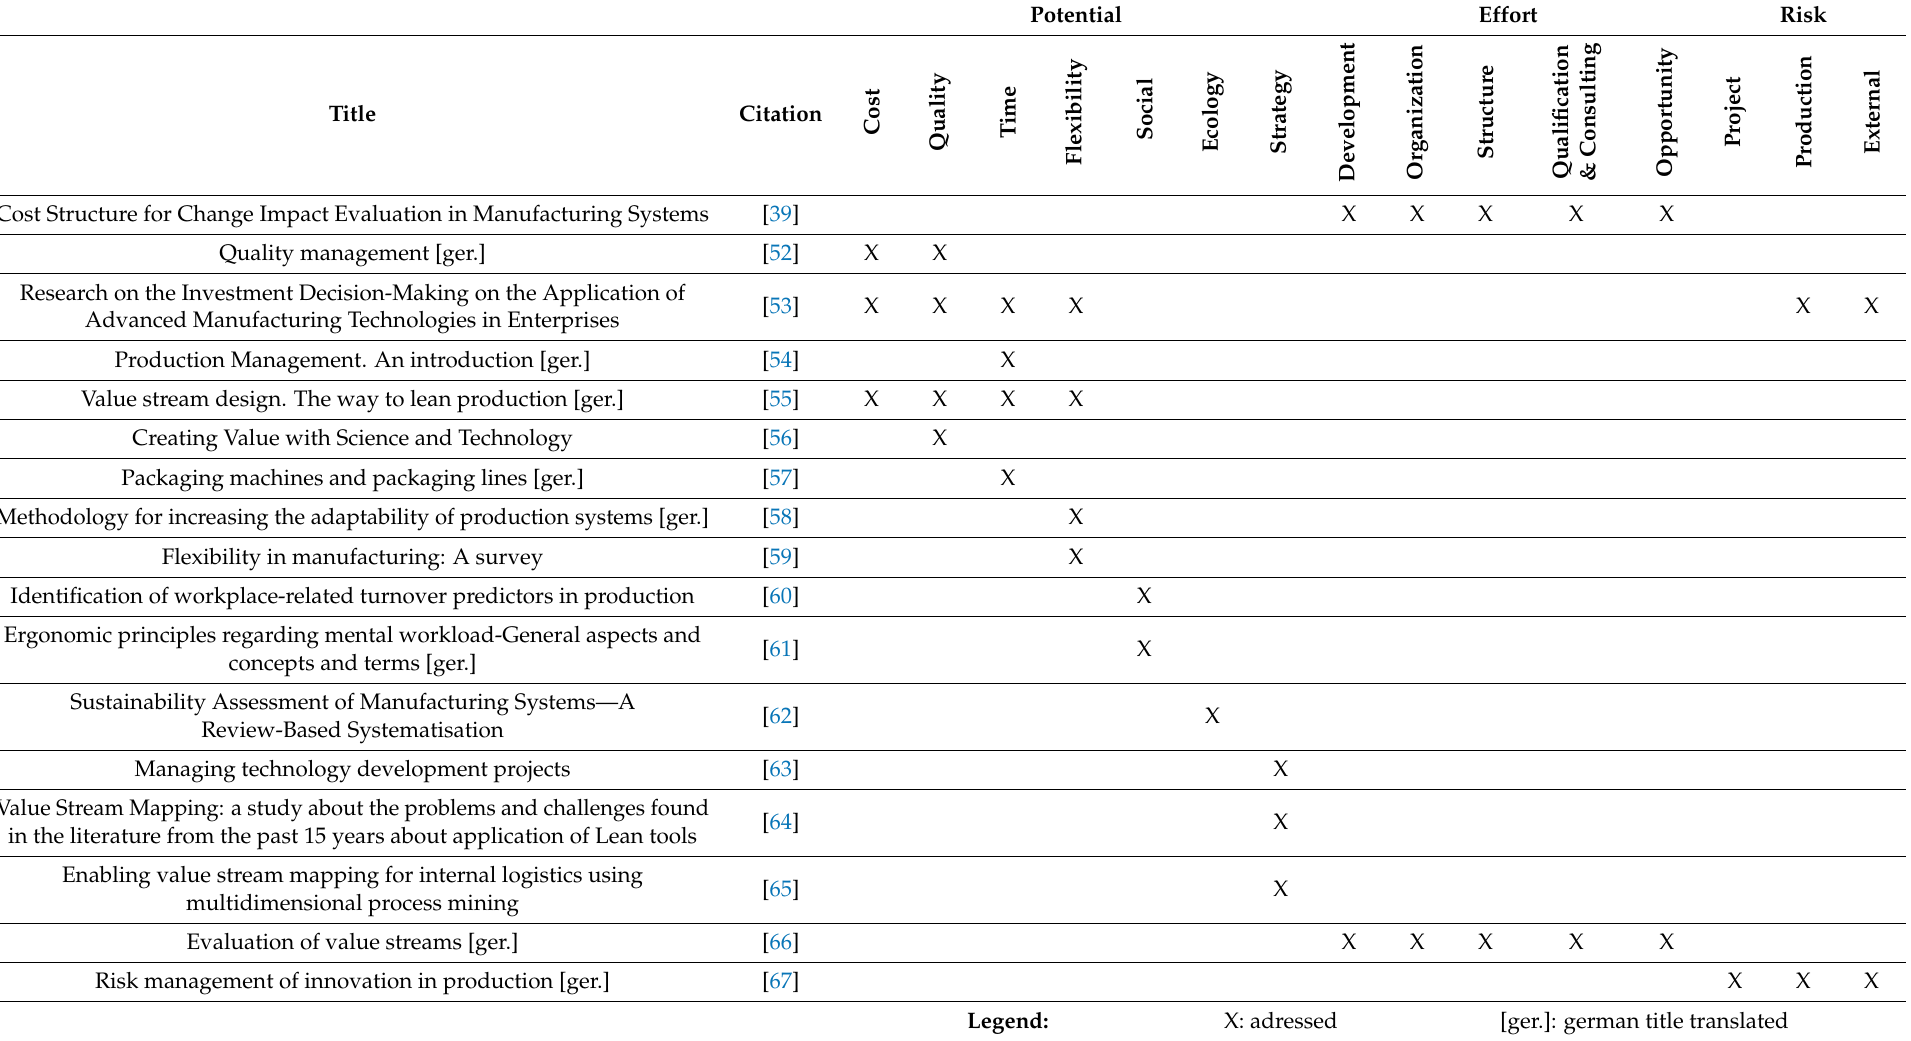
Table 3. Excerpt of the used sources for the derivation of assessment criteria. Potential Effort